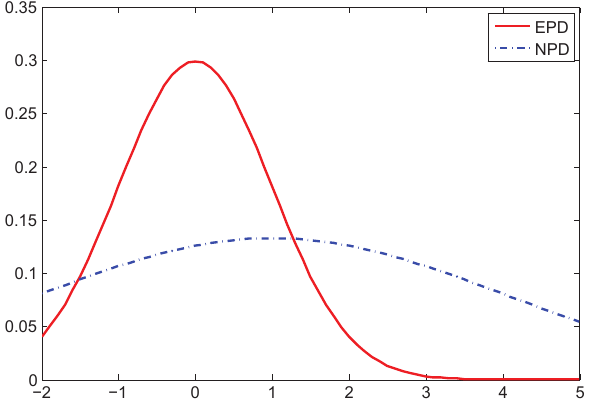
Figure 6. The dynamic Gaussian model (DGM) pattern in the the